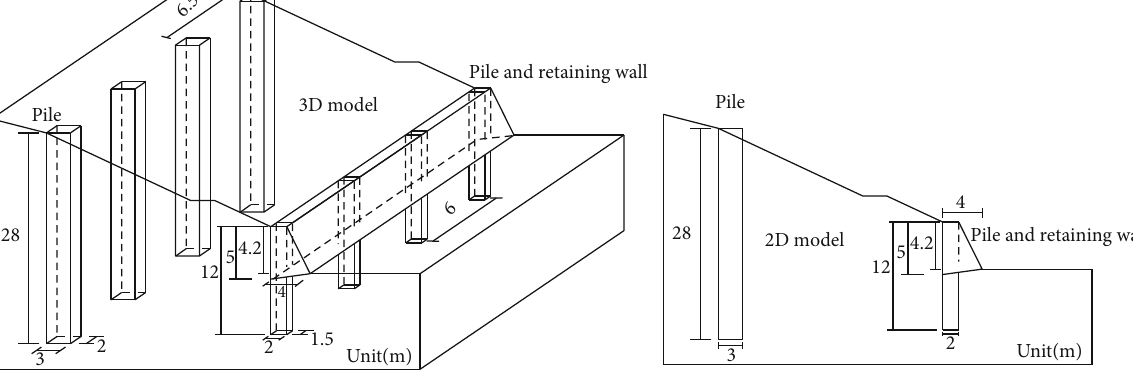
Figure 5: 3D and 2D calculation